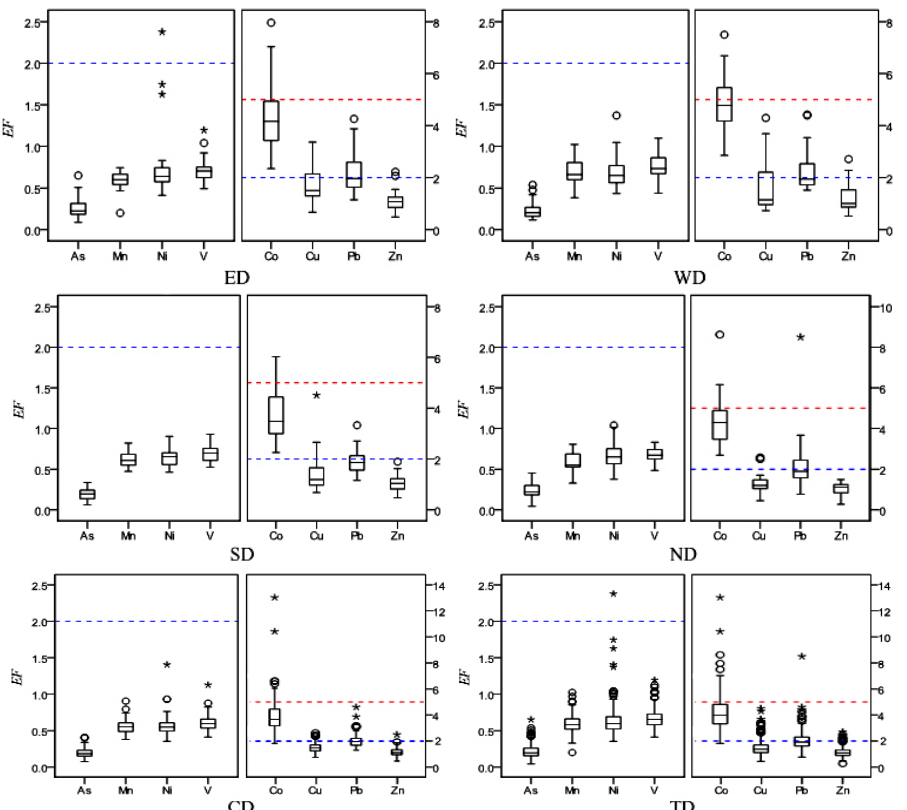
Figure 3. Box-plots of EF for ESEs in smaller than 100 μm street dust particles from Xining (ED: East District; WD: West District; SD: South District; ND: North District; CD: Central District; TD: Total District; ° : outlier; * :